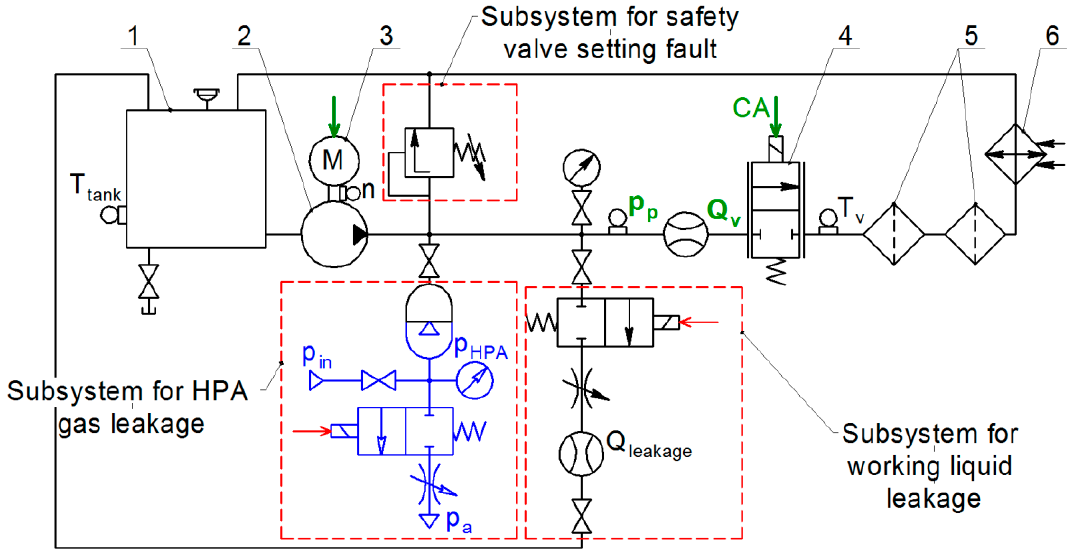
Figure 2. A diagram of a typical hydraulic system (working fluid supply station) modelling the faults: CA—control action; TS—temperature sensor; RS—rotational velocity sensor; PS—pressure sensor; FS—flow rate